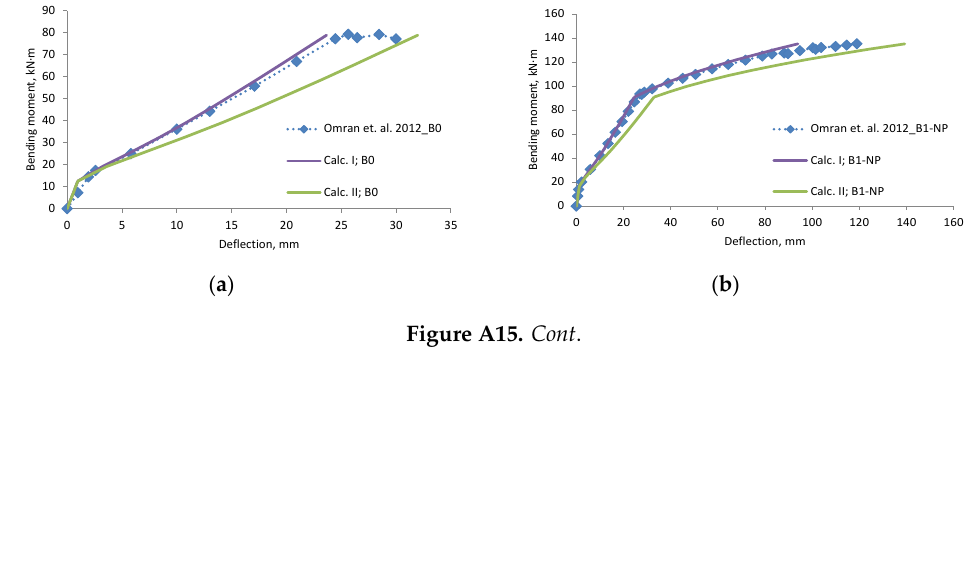
Figure A14. Kotynia et al., 2014 [37] research beams deflection compared with calculated, ( a ) beam B12; ( b ) beam b12-a; ( c ) beam B12-asp; ( d ) beam B12-asp-e; ( e ) beam B16; ( f ) beam B16-asp; ( g ) beam B16-asp-e; ( h ) scatter of the results at 60% and 80% of the ultimate load.